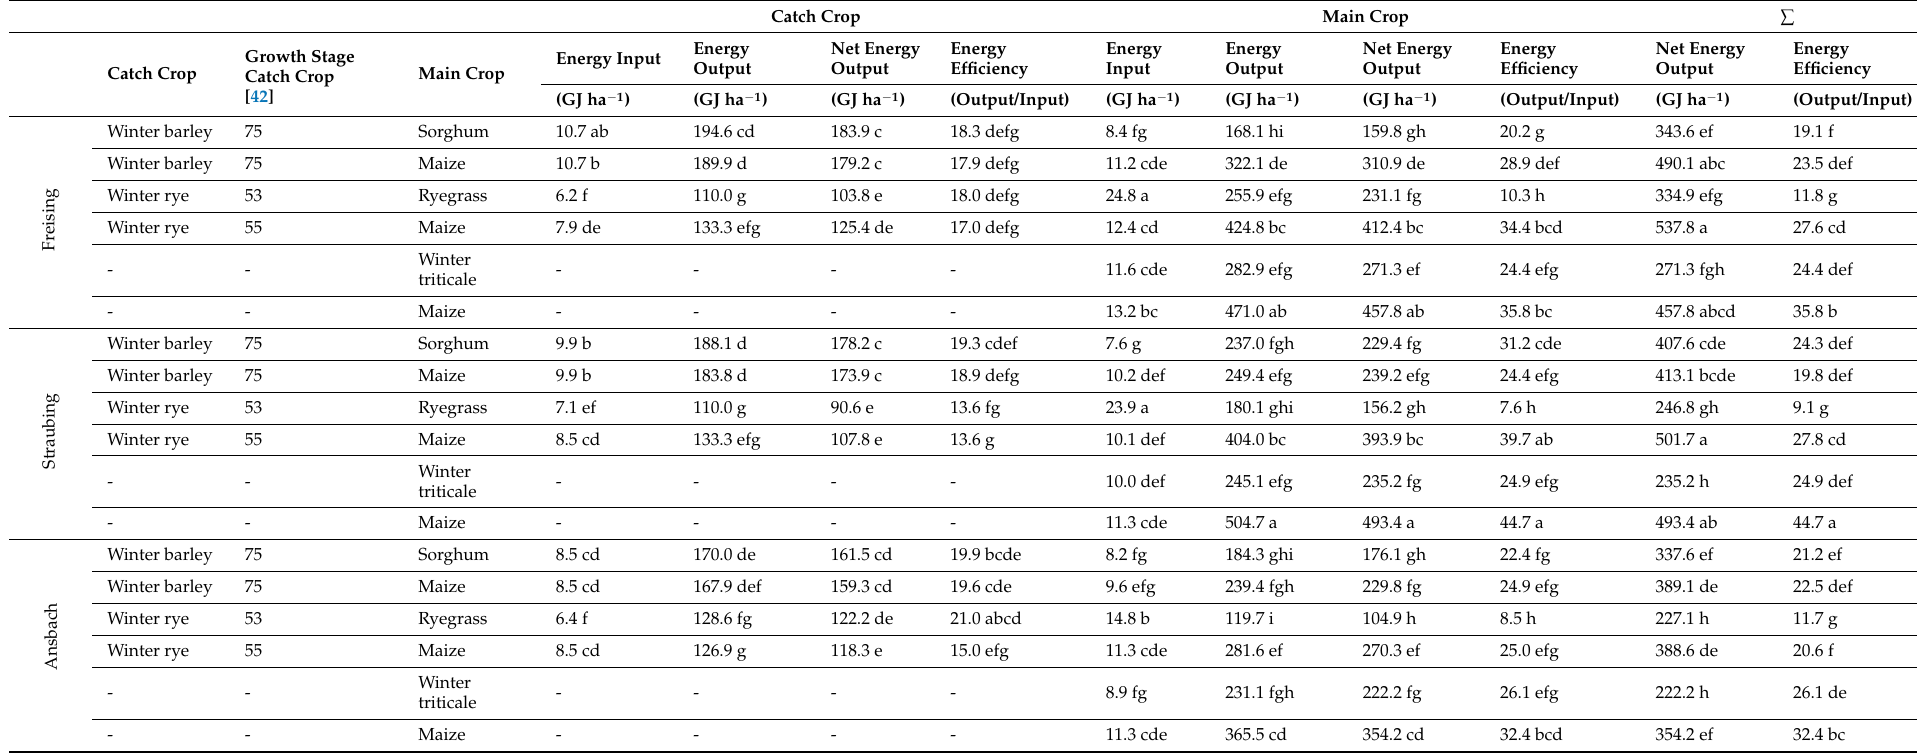
Table 6. Energy balance at the experimental sites (mean values across all experimental years). Column-wise differences marked with letters. Catch Crop Main Crop